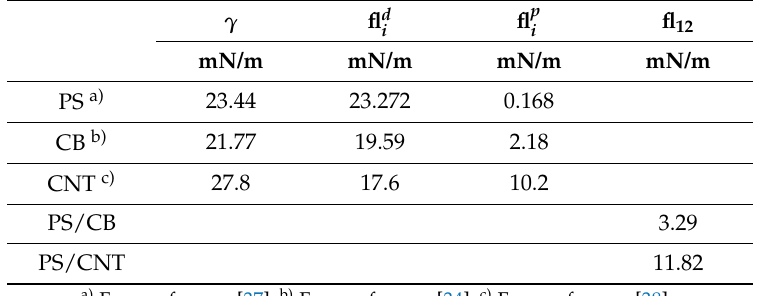
Table 2. Surface tension of pure components and the interfacial tension of PS-filler at 260 ◦ C.